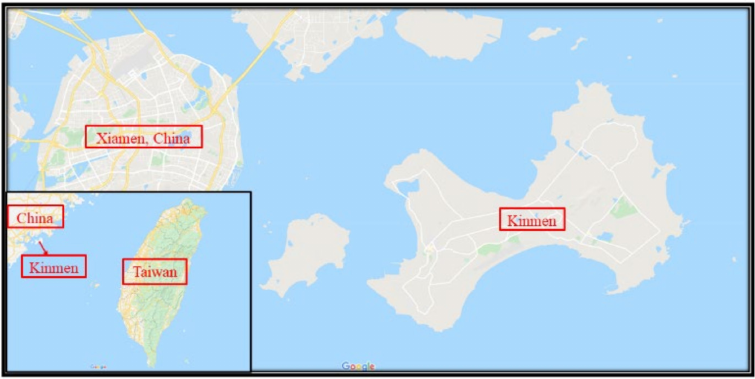
Figure 1. Location of Taiwan, Kinmen and the archipelago of Xiamen from Google